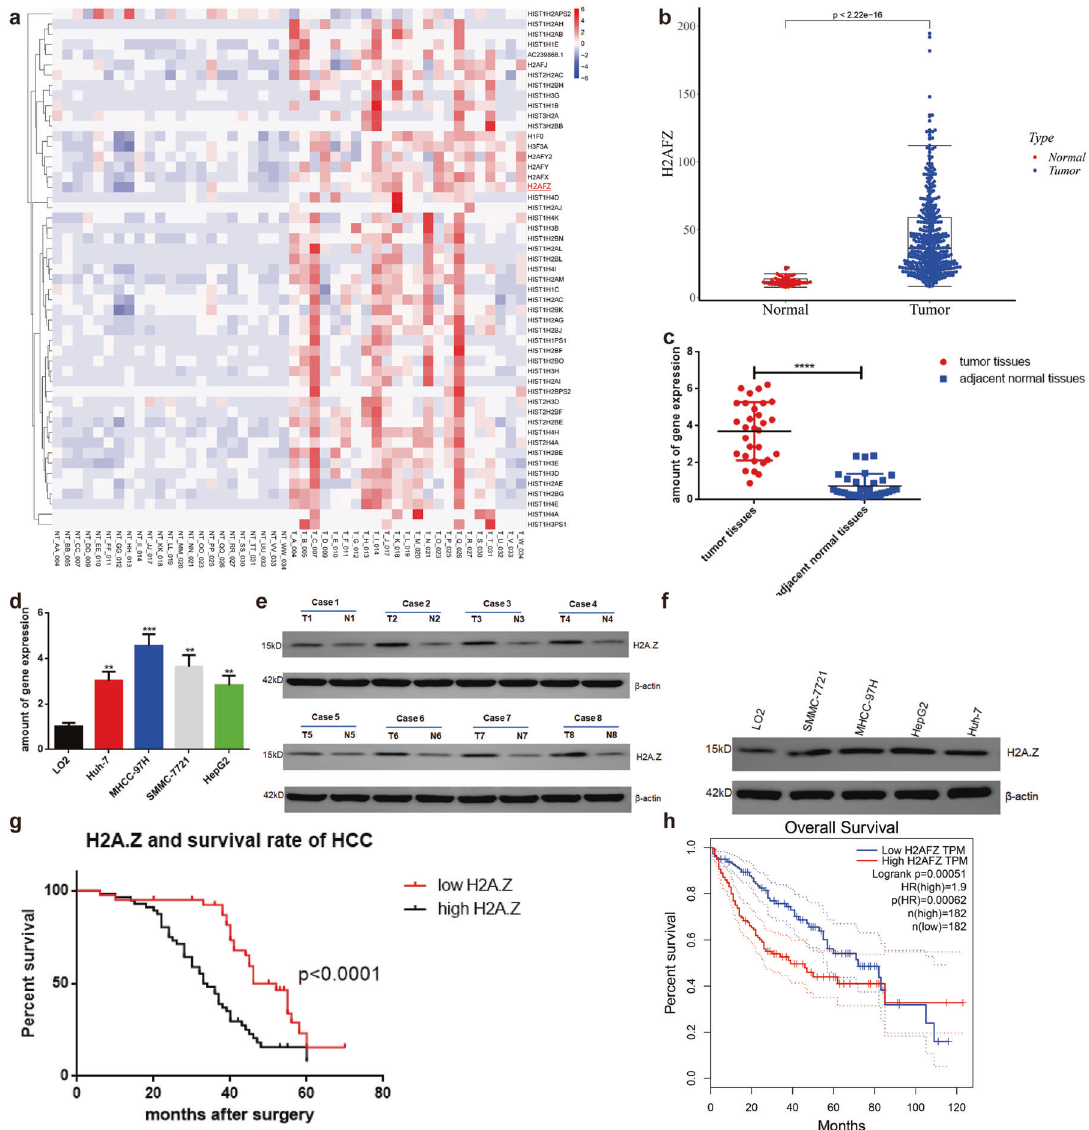
Fig. 1 H2A.Z is highly expressed in HCC tissues and cells and is associated with the prognosis in patients with HCC. a Heat maps of histones and variants in 23 HCC and paired paracancer tissues analyzed using RNA-seq(Software: R pheatmap, Algorithm: ward2). b H2A.Z transcript between HCC tissues and normal liver tissues was analyzed in the publicly accessible samples(TCGA http://gepia.cancer-pku.cn/; T = 375, N = 50)(Software: beeswarm, R package). c Scatter plots comparing H2A.Z expression in HCC samples and normal liver tissue samples detected by qPCR(Student ’ s t -test used in Fig c , n = 30 in each group). d The expression levels of H2A.Z in human HCC cells were detected by qRT-PCR. e Expression levels of H2A.Z protein were detected in 8 matched HCC samples by western blot ( N , normal tumor-adjacent tissue; T , tumor tissue). f Expression levels of H2A.Z protein were detected in HCC cell lines by western blot. g Kaplan-Meier survival curves illustrating the overall survival and disease-free survival of patients with HCC associated with H2A.Z expression in 96 cases. h The negative correlation between H2A.Z expression and overall survival was analyzed on the basis of TCGA data in patients with HCC(Software: survival, R package). The data are expressed in terms of mean ± SD(Student ’ s t -test used in Fig d and Kaplan-Meier test used in Fig g ; ** P < 0.01; *** P < 0.001; **** P < 0.0001; n = 3 in each Z in HCC cells. Stable H2A.Z-knockdown (sh_H2A.Z-1 and sh_H2A. found to be independent clinical predictors of overall survival rate Z-2) and -overexpression (clone_H2A.Z-1 and clone_H2A.Z-2) and recurrence rate in HCC (Table 1). Importantly, high H2A.Z HepG2 and MHCC-97H cell lines were established (Fig. 2A). Based levels in HCC signi fi cantly predicted poor outcomes in patients on WB results, the HepG2 cell line was selected for sh_H2A.Z-1 with HCC (Fig. 1G). In addition, online analysis based on TCGA data and clone_H2A.Z-2, and the MHCC-97H cell line was selected for (http://gepia.cancer-pku.cn/) showed H2A.Z levels to be negatively sh_H2A.Z-1 and clone_H2A.Z-1 in experiments investigating cell correlated with the overall survival of patients with HCC (Fig. 1H). tumorigenic properties. Their proliferation ability was determined by the MTT assay. As shown in Fig. 2B, H2A.Z knockdown H2A.Z promoted the proliferation of HCC cell, reduced their decreased the proliferation of HCC cells while its overexpression apoptosis, and aided invasion and metastasis increased the same. Transwell cells without matrix gel were used Since H2A.Z was overexpressed in HCC, knockdown and gain-of- to compare the difference in migration ability of the stable function approaches were employed to determine the role of H2A.